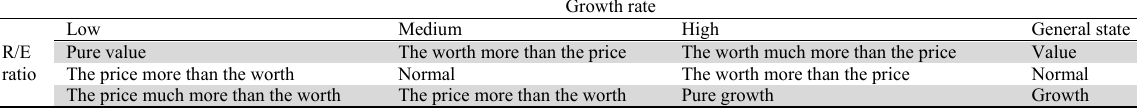
Corporations Grouping